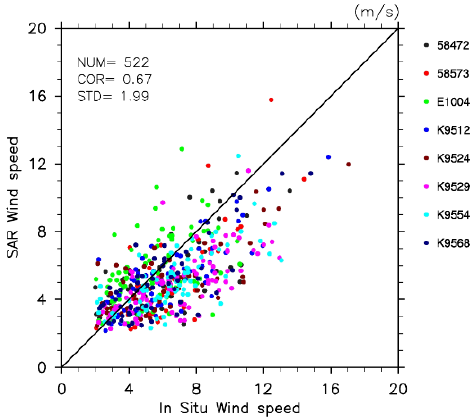
Figure 5. In situ wind speeds from eight meteorological stations vs. SAR wind speeds. The number of samples is